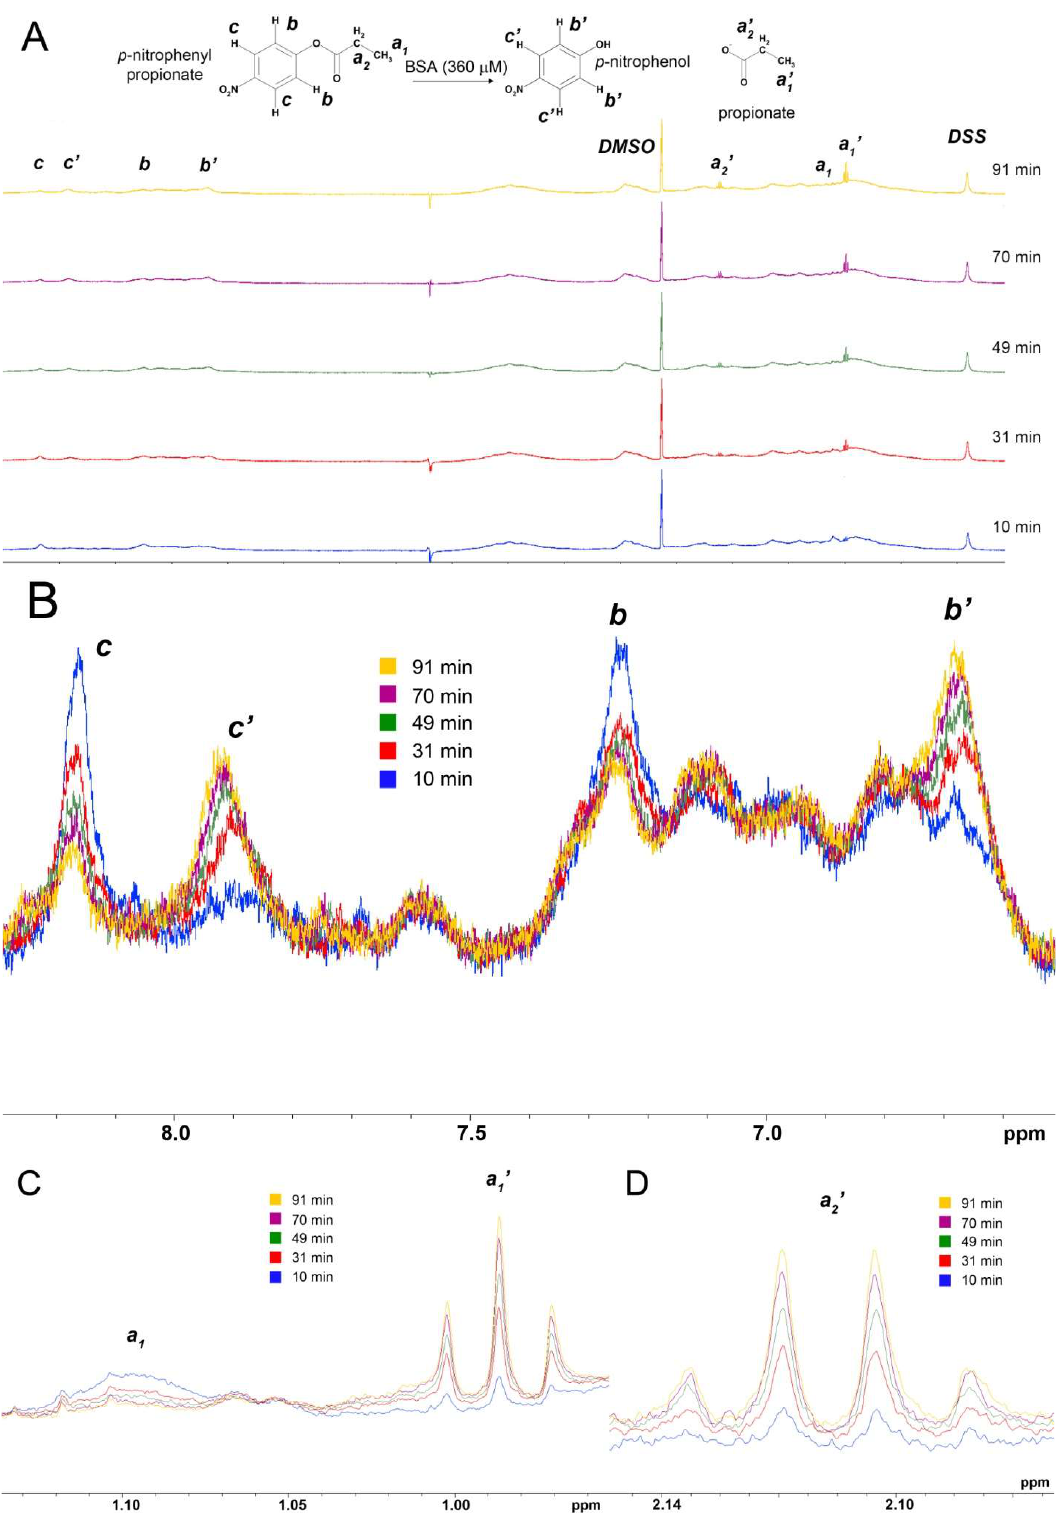
Figure 10. Kinetics of p -nitrophenyl propionate (NPP) hydrolysis in the presence of BSA according to 1 H NMR. ( A ) full spectrum; ( B ) aromatic region of the spectrum; ( C ) signals of the CH 3 -group of NPP (left) and CH 3 -group of free propionate (right); ( D ) signal of CH 2 -group of free propionate. Internal standard sodium trimethylsilylpropanesulfonate is labelled as DSS; dimethyl sulfoxide is labelled as